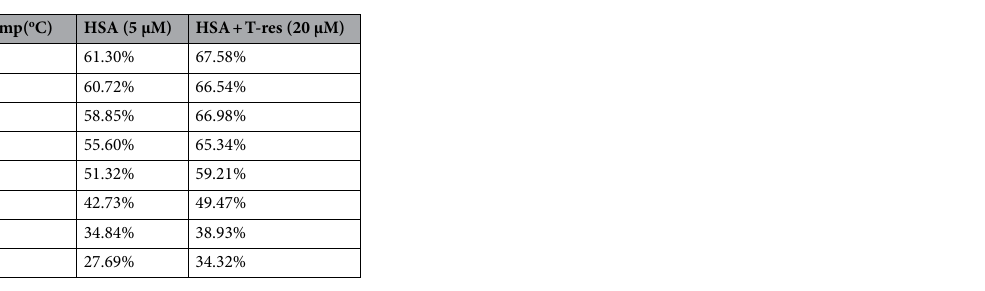
Table 3. Table showing alpha-helical content in HSA and HSA + T-res system as a function of temperature ranging from 20 to 90 °C at pH 7.4.